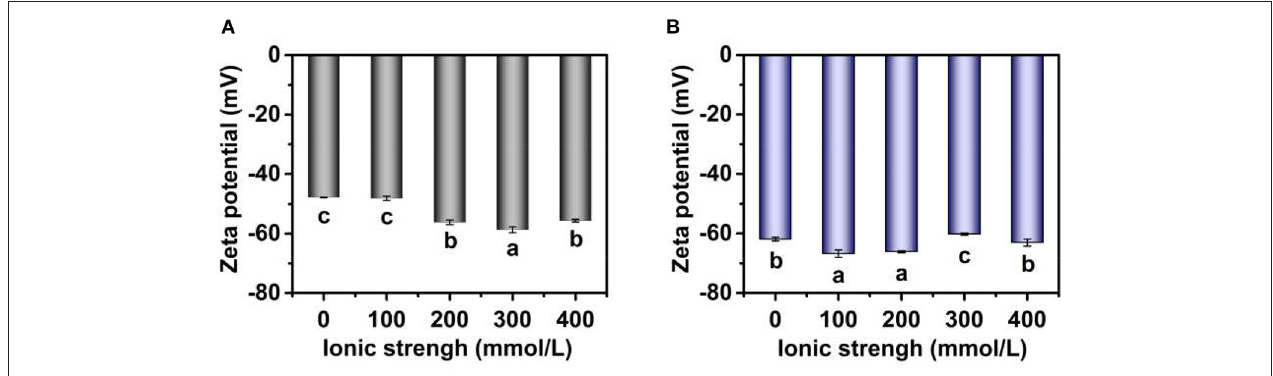
FIGURE 4 | Zeta potential of Pickering emulsions by tea water-insoluble protein nanoparticles under different ionic strengths [ (A) emulsions in water; (B) emulsions in 1.0% SDS]. The lowercases indicate the significance of different Pickering emulsions by tea water-insoluble protein nanoparticles under different ionic strengths ( P < 0.05).